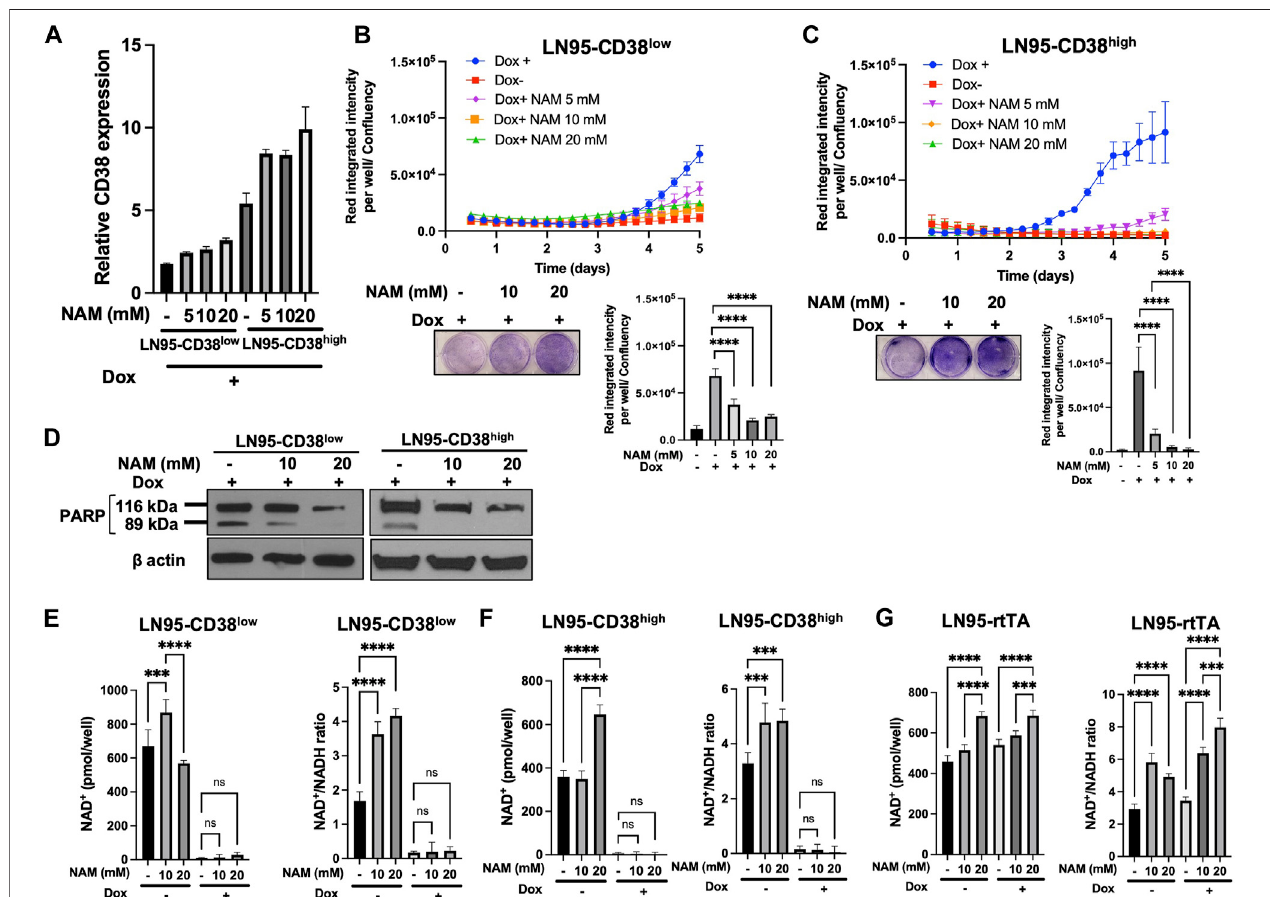
FIGURE 4 | Rescue of CD38-induced apoptosis by NAM. (A) CD38 expression level determined by qRT-PCR following 100 ng/ml Dox and NAM for 48 h (B,C) Apoptosis assay by IncuCyte and crystal violet staining in LN95-CD38 low (B) and LN95-CD38 high (C) . Mean ± SD values from four replicates are shown. p values for Turkey ’ s multiple comparison tests are indicated in each fi gure. Crystal violet staining was performed on Day 4. ****: p < 0.0001. (D) Western blots showing inhibition of CD38-induced PARP1 cleavage by NAM. (E,F,G) Measurements of NAD + and NAD + /NADH ratios in LN95-CD38 low (E) , LN95-CD38 high (F) , and LN95-rtTA